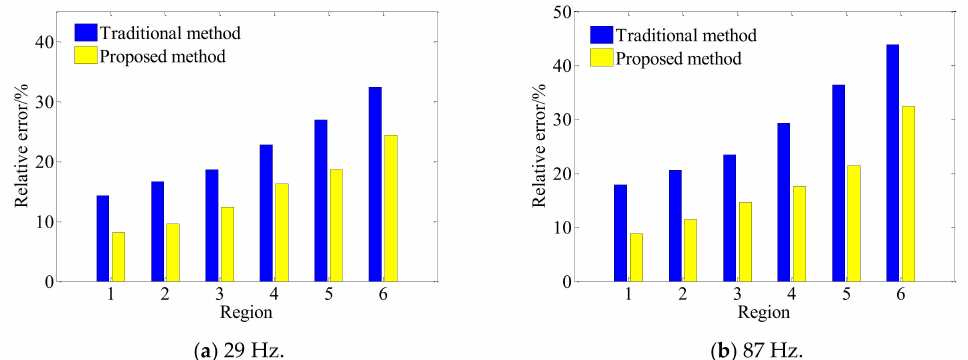
Figure 27. Reconstruction by the traditional and proposed method.